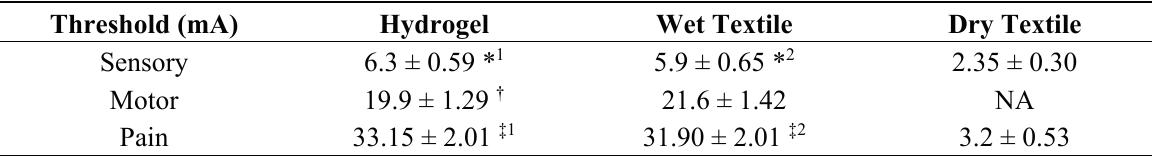
Table 3. Comparison of the mean stimulation thresholds of sensory, motor and pain for different types of electrode. Statistical results are expressed as mean ± S.E.M. NA denotes not